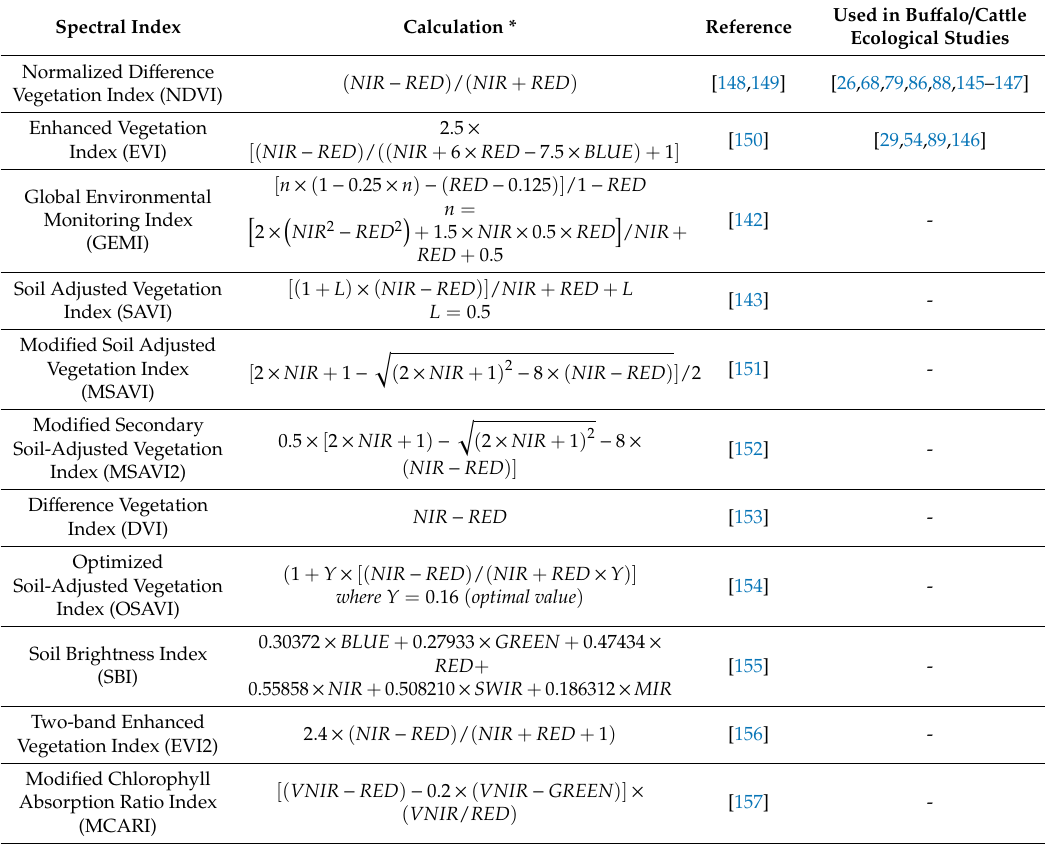
Table 3. Non-exhaustive list of spectral remote sensing indexes developed to discriminate vegetation and soil from optical satellite image analysis and that can be useful within the frame of animal movement studies in savanna